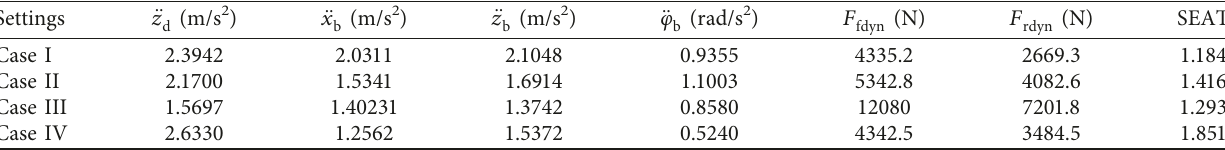
Table 2: RMS of vibration responses and SEAT values for the tractor/implement system under different settings. Settings € z (m/s 2 d